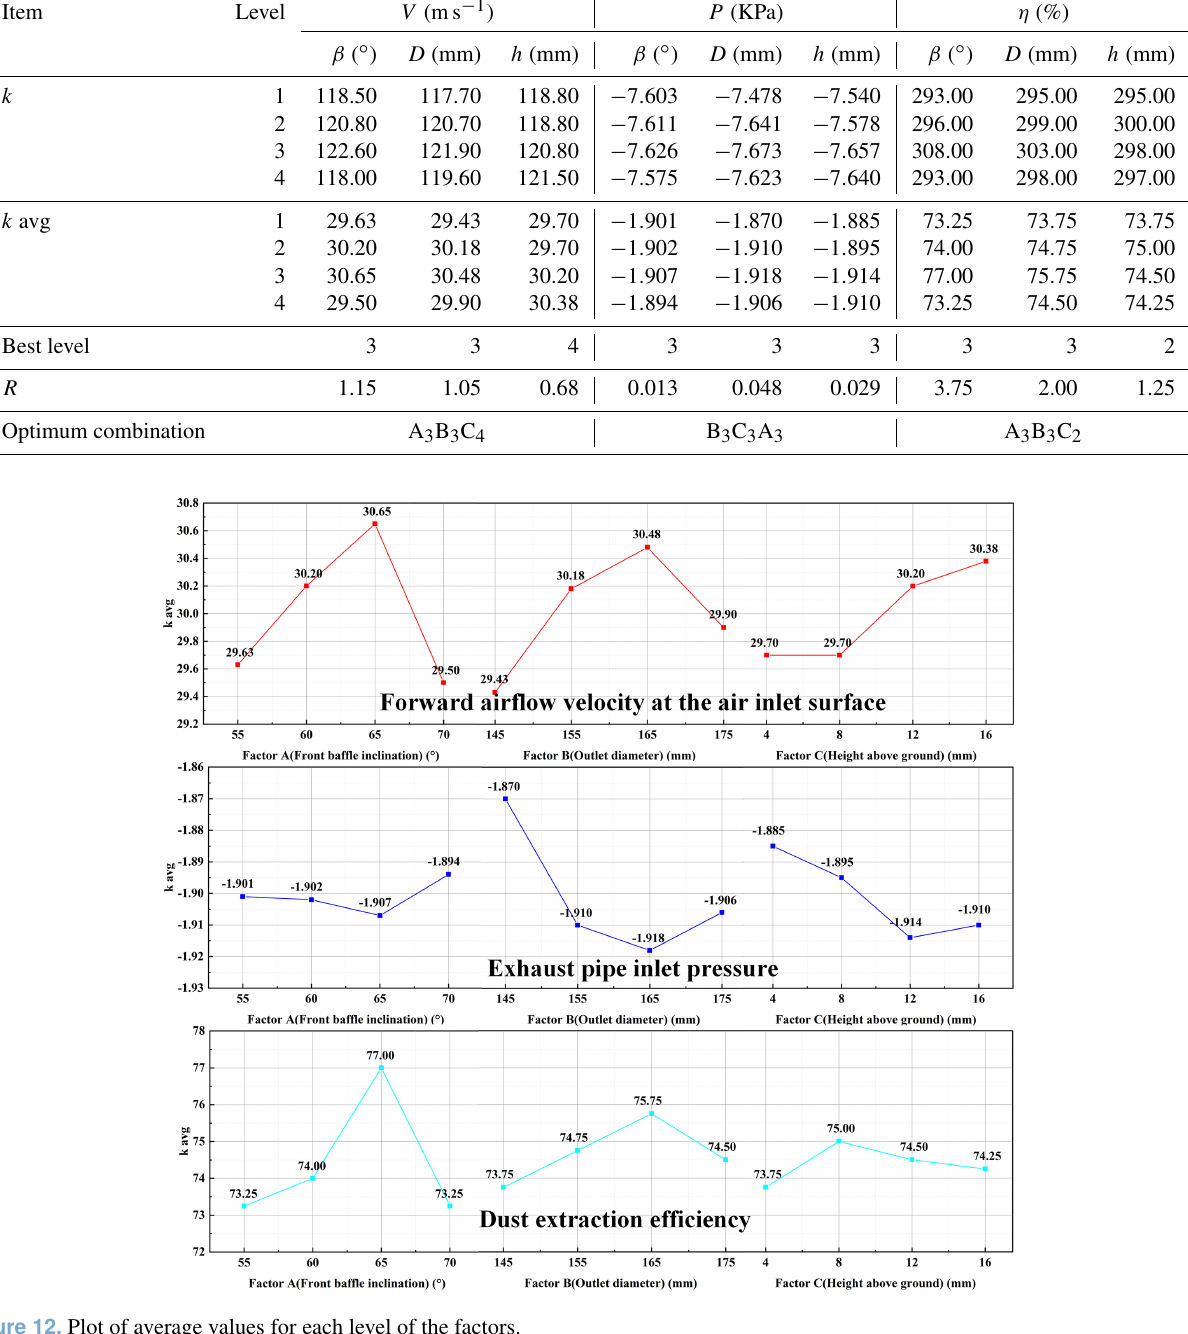
second level of height above the ground, i.e. 8